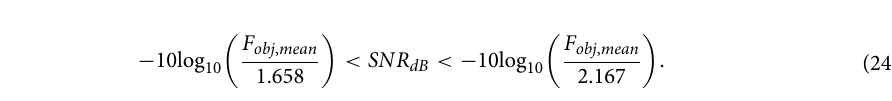
Figure 11. Normal distribution fit based on twenty experiments with different streams of random numbers with SNR of 80 dB.